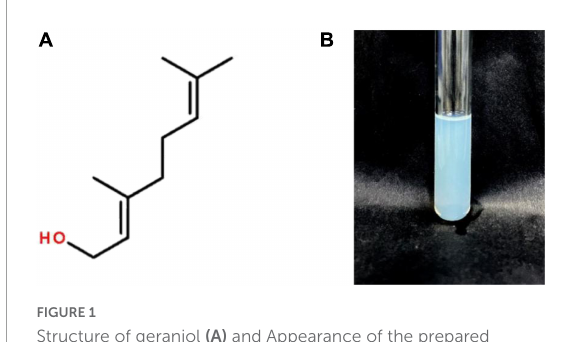
FIGURE1 Structure of geraniol (A) and Appearance of the prepared G-NE (B) .